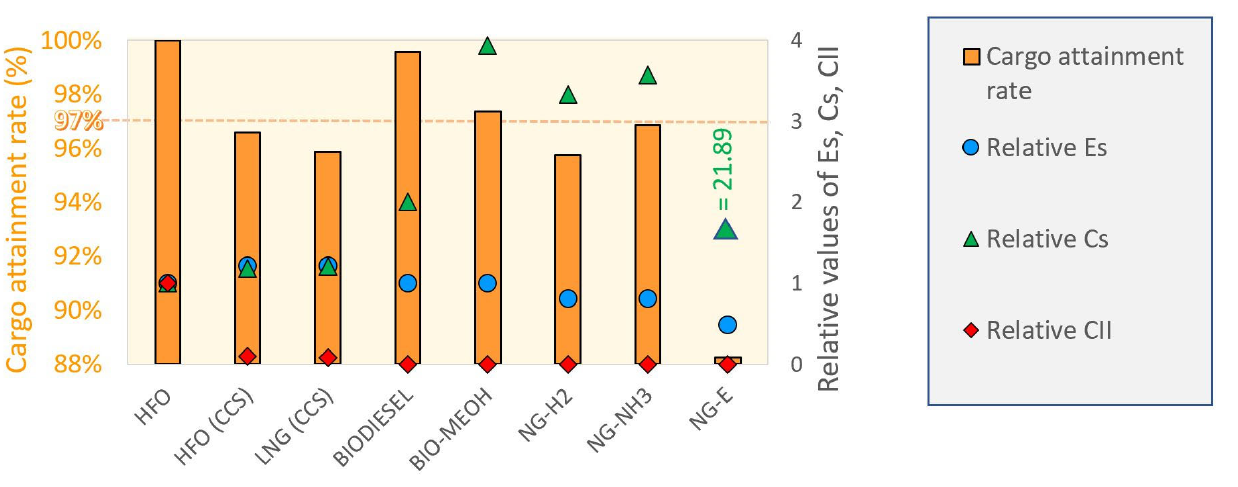
Figure 8. Cargo attainment rate (clustered columns) and relative values of Tank-To-Wake energy unit